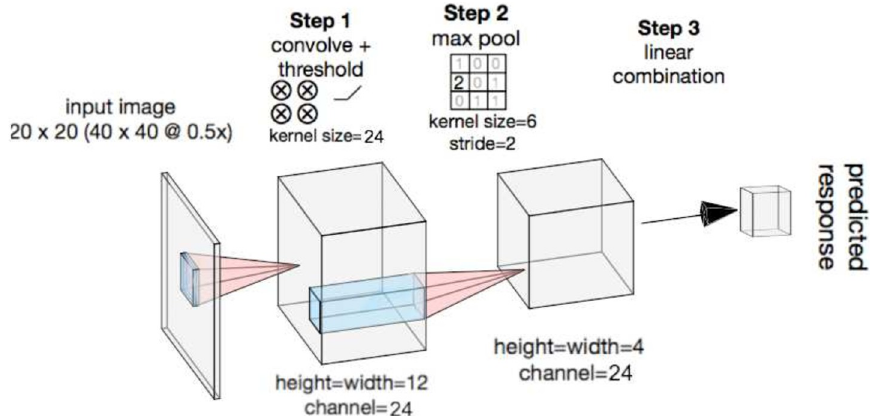
Fig 4. Structure of CNN. The input image is of size 20 × 20 pixels, downsampled from the 40 × 40 image of the experimental stimulus centered at the neurons’ aggregated receptive fields. The model has three stages: convolution and thresholding, max-pooling, and a final fully-connected linear combination to generate the predicted neuronal response.